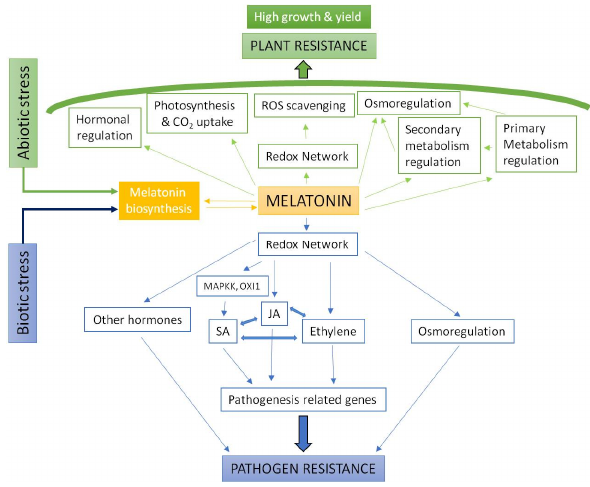
Figure 1. Model of redox network/melatonin action on abiotic and biotic stress responses.